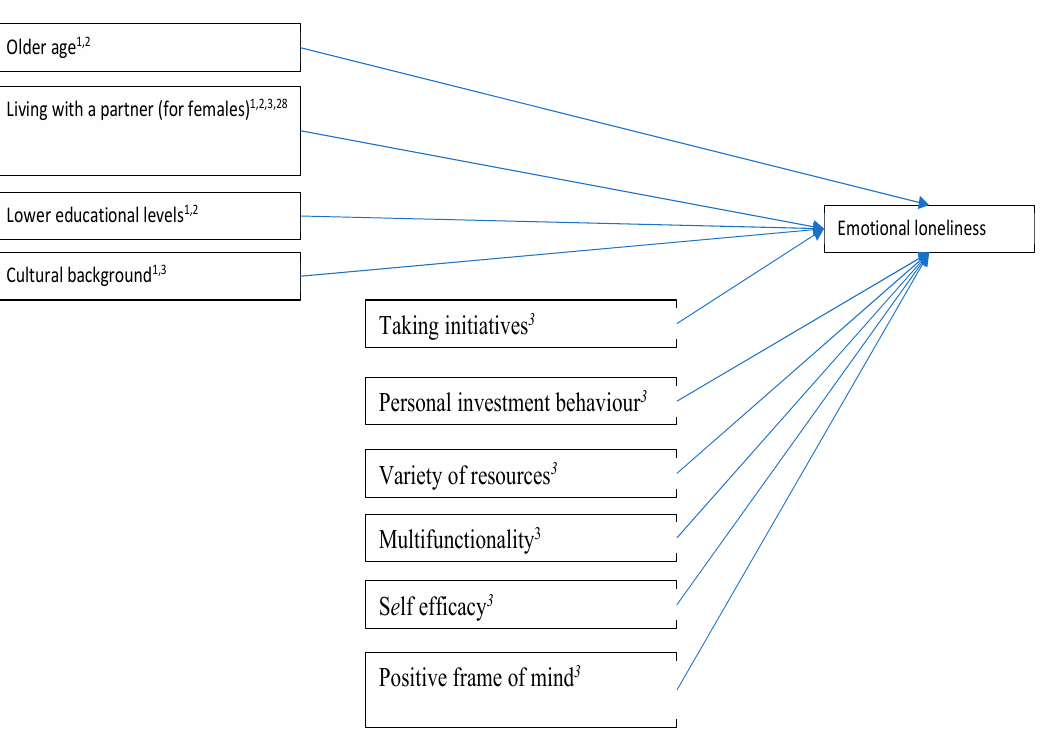
Figure 2. Antecedents to emotional loneliness. 1. Fierloos et al. (2021); 2. Gibney et al. (2019); 3. Nieboer et al. (2020); 28. Evans et al. (2019).